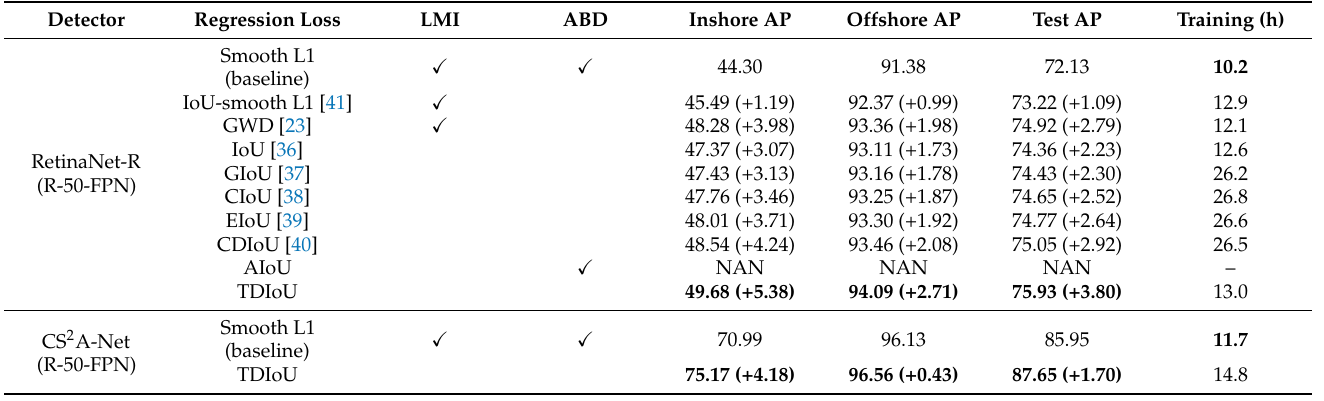
Table 4. Comparison of different regression losses on RSSD. Here, R-50-FPN denotes ResNet50 with FPN, LMI and ABD denote the loss-metric inconsistency and angular boundary discontinuity, respectively, and (cid:88) indicates that the method has corresponding issue. Training represents the total training time (in hours) for 72 epochs with a single GPU and a batch size of 2. Bold items are the best result of each